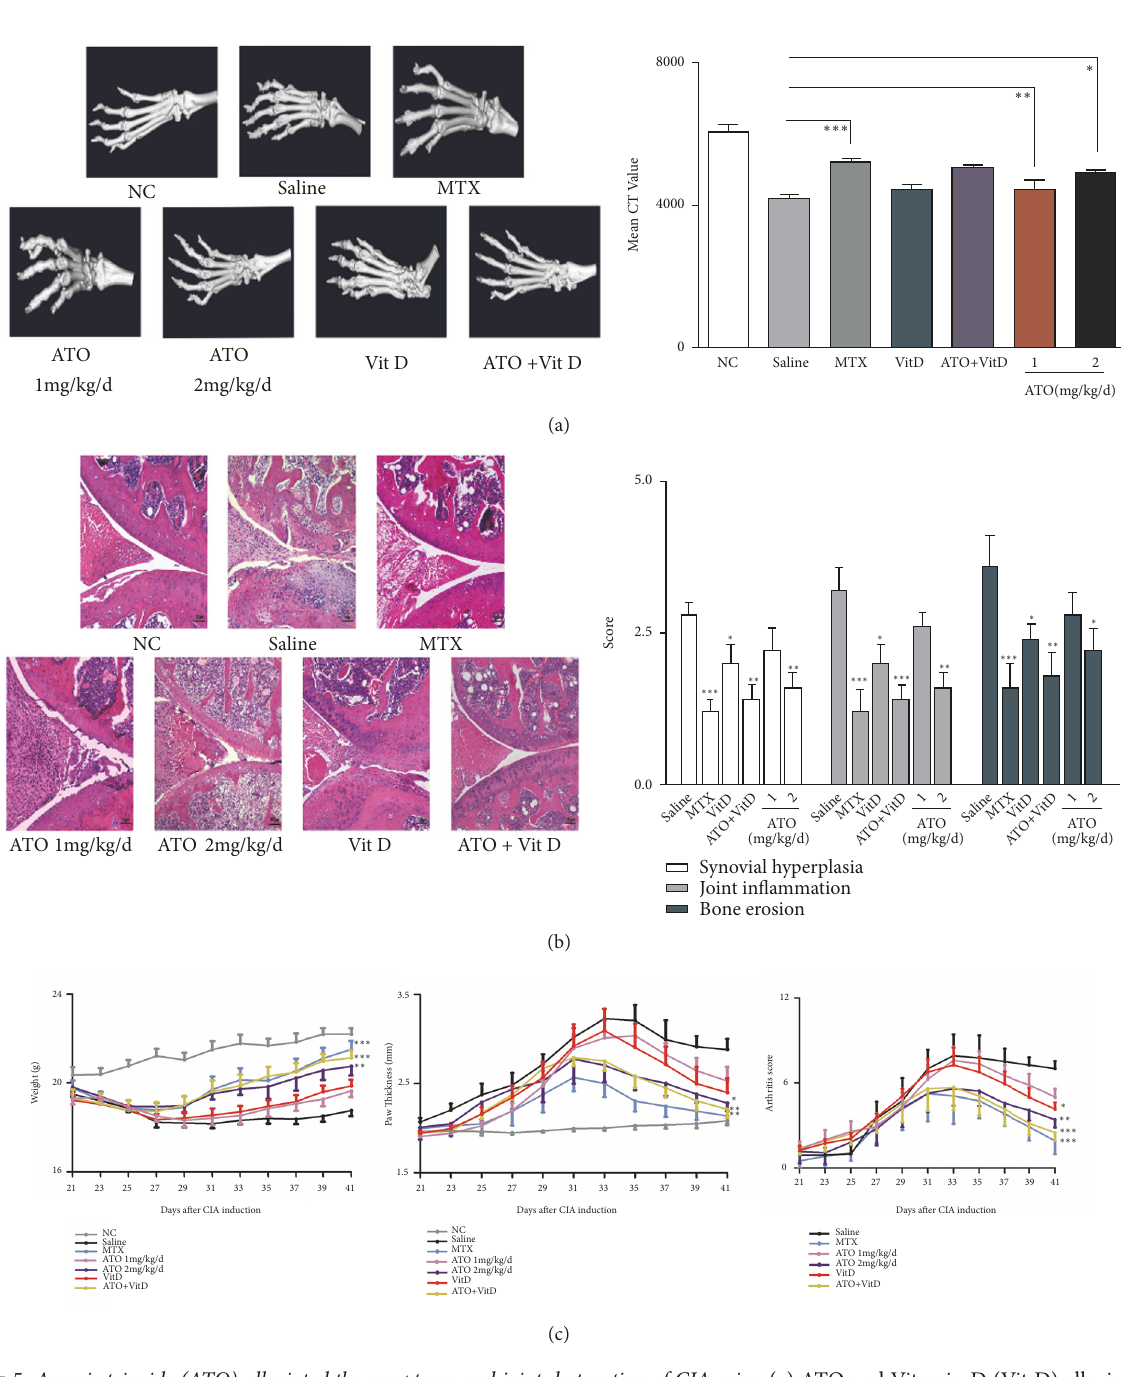
Figure 5: Arsenic trioxide (ATO) alleviated the symptoms and joint destruction of CIA mice . (a) ATO and Vitamin D (Vit D) alleviate joint destruction and significantly elevated mean CT values in collagen-induced arthritis (CIA) mice compared with normal control (NC) mice ( n =6; ∗ p < 0.05, ∗∗ p < 0.01, ∗ ∗ ∗ p < 0.001). Data are expressed as mean ± SEM. (b) The severity of arthritis in CIA mice was measured by H&E staining of knee joints. ATO treatment (2mg/kg/d) and Vit D (400ng/kg/d) significantly reduced the histological scores, including synovial hyperplasia, cartilage and bone erosion, and joint inflammation compared with NC ( n =6; ∗ p < 0.05, ∗∗ p < 0.01, ∗ ∗ ∗ p < 0.001). Magnification = 20 × . Bars = 50 𝜇 m. Data are expressed as mean ± SEM. (c) Collagen-induced arthritis- (CIA-) saline mice (saline) showed a significant decrease in weight and increased paw thickness and arthritis scores compared with the normal control (NC) group. Arsenic trioxide (ATO) at 2.0mg/kg/day, Vitamin D (Vit D), and methotrexate (MTX) (n=6) significantly increased bodyweight and decreased paw thickness and arthritis scores (n=6, ∗ p < 0.05, ∗∗ p < 0.01, ∗ ∗ ∗ p < 0.001, treatment versus saline). Data are expressed as means ±